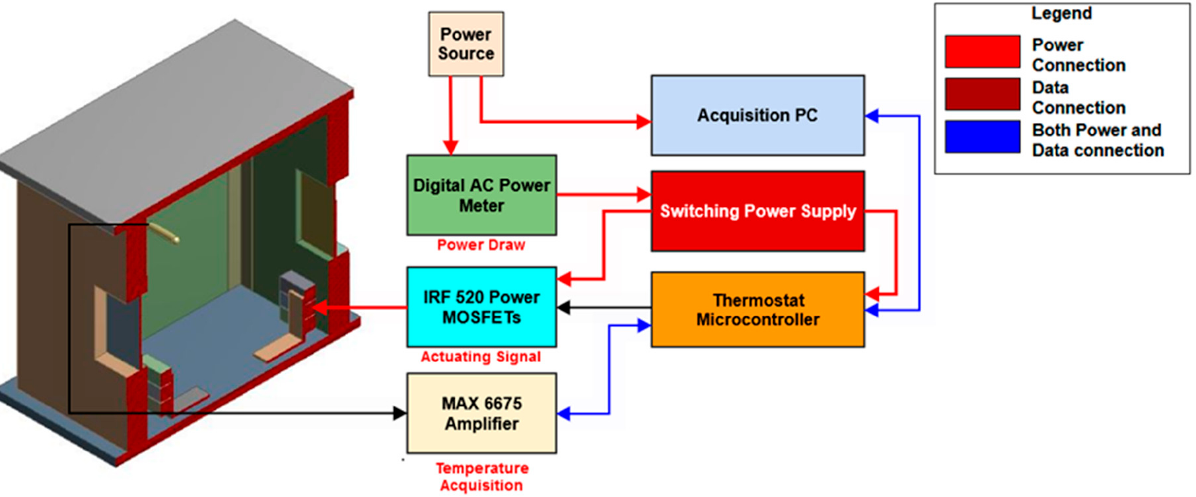
Figure 8. Schematic representation of the thermostat and temperature acquisition